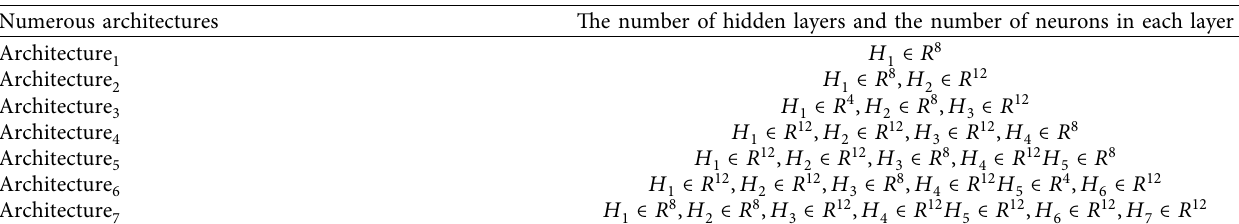
Table 6: The different architectures of MLP with the corresponding number of hidden layers and the number of neurons in each layer. Numerous architectures The number of hidden layers and the number of neurons in each